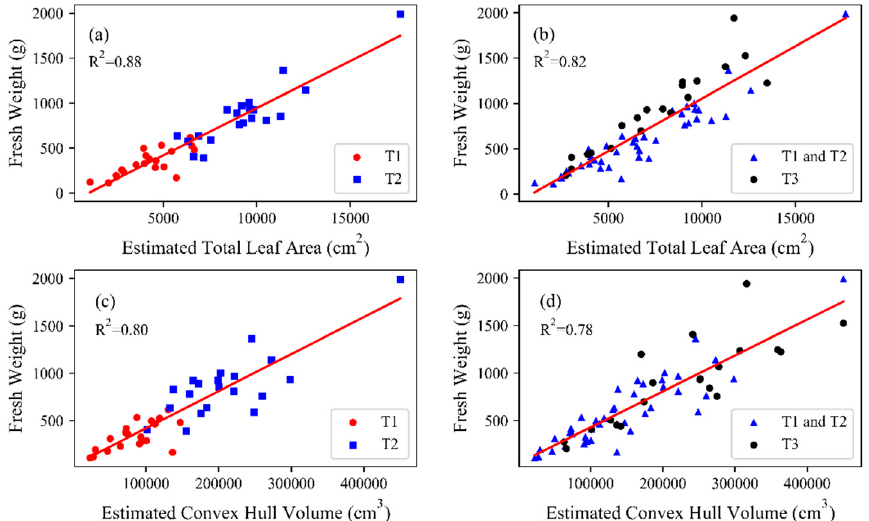
Figure 13. Correlation of estimated traits and fresh weight: ( a ) Estimated total leaf area and fresh weight at stages T1 and T2; ( b ) Estimated total leaf area and fresh weight at stages T1, T2 and T3; ( c ) Estimated convex hull volume and fresh weight at stages T1 and T2; ( d ) Estimated convex hull volume and fresh weight at stages T1, T2 and T3.